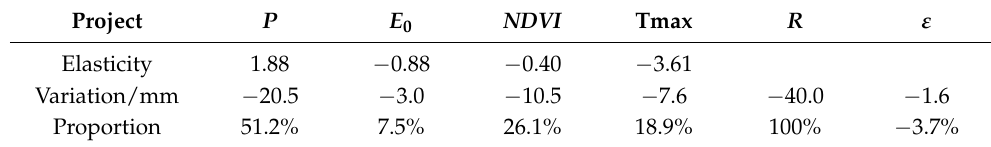
Table 4. Elasticity and change of runoff induced by climate change and ecological